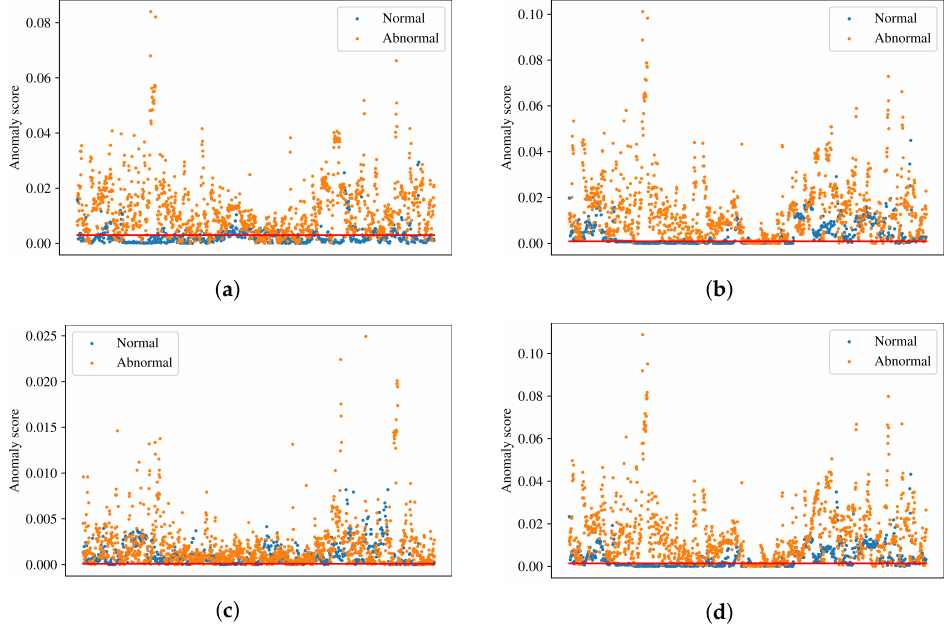
Figure 5. Distribution of normal and abnormal samples from the test set. ( a ) SSAE, thr = 0.003. ( b ) AE, thr = 0.0009. ( c ) VQ-VAE, thr = 0.0001. ( d ) DAE, thr = 0.0014. The qualitative performance of the autoencoder models is presented in Figure 6. The example image is captured by the front camera of the combine harvester during field operation. In this scenario, the tractor with a trailer and the car are potential